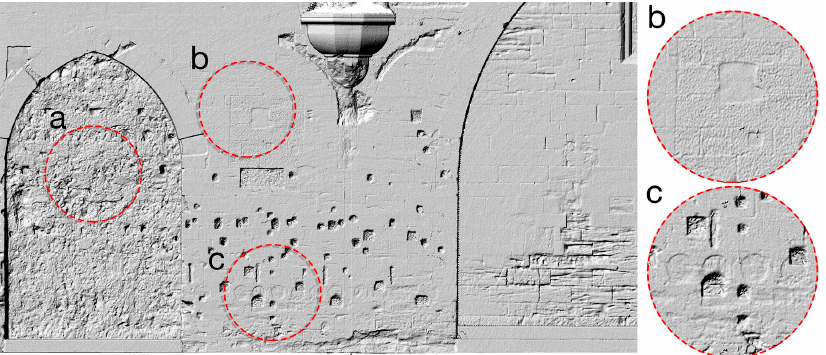
Figure 6. Raster hillshade 315° azimuth 45°: ( a ) surface roughness not visible from photographs, ( b ) surface roughness not visible to the naked eye, and ( c ) carved symbols, barely visible on site.